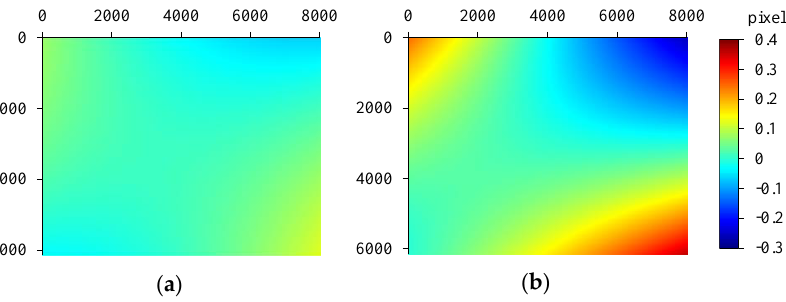
Figure 7. Differences of offset polynomials between the standard method and the proposed method in range ( a ) and azimuth ( b ).